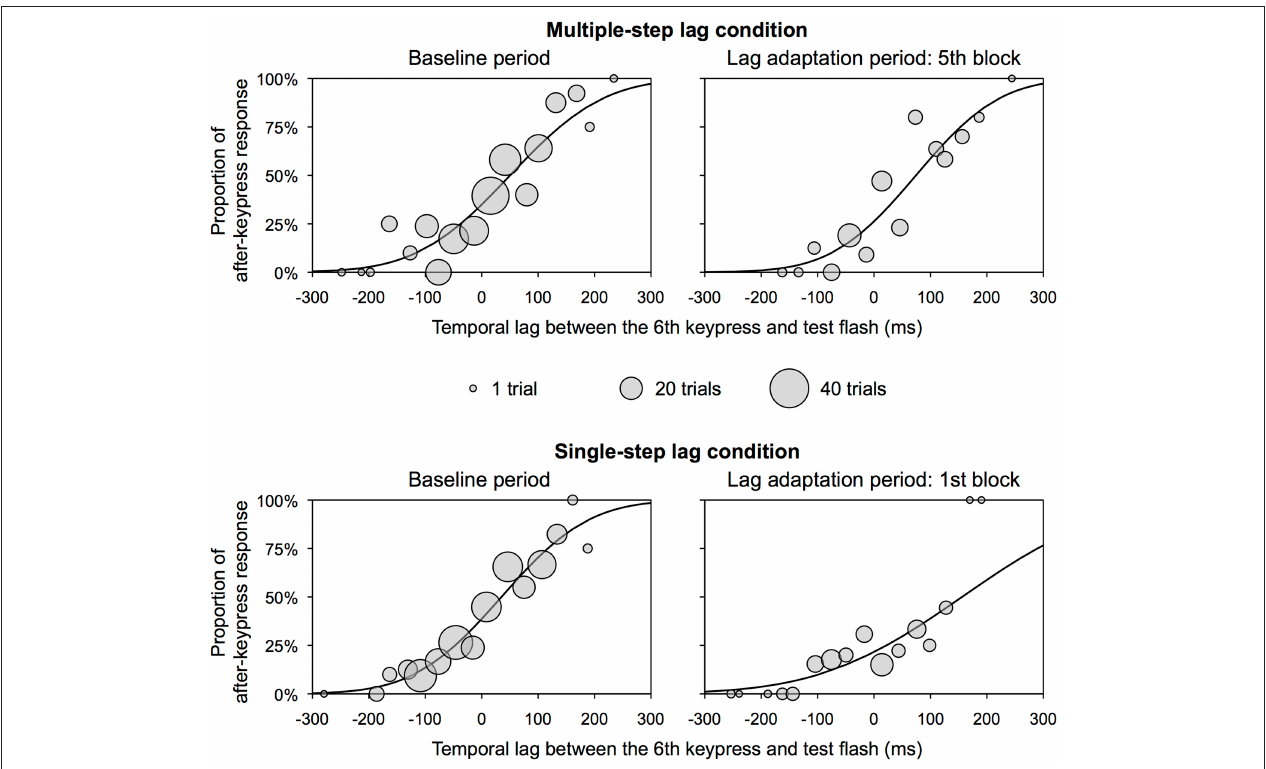
FIGURE 2 | Representative psychometric function for each condition in Experiment 1. These functions were obtained by the use of all observers’ data. Circles show the proportion of after-keypress response in each bin. Circle size shows the number of trials in each bin. A temporal lag between the sixth keypress and test flash on x -axis does not contain any inevitable delay due to a computer system.